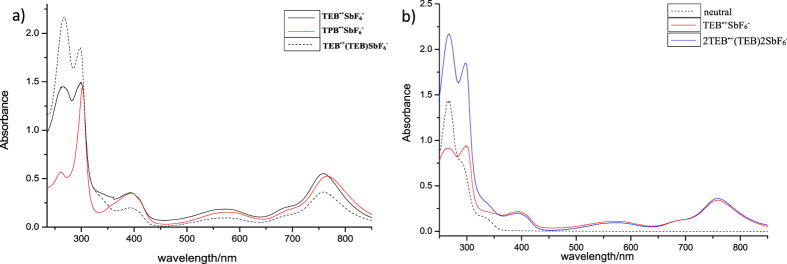
(a) Absorption spectra of ,  and ; (b) Absorption spectra of neutral TEB,  and  (10−5 M in CH2Cl2 at 25 °C).